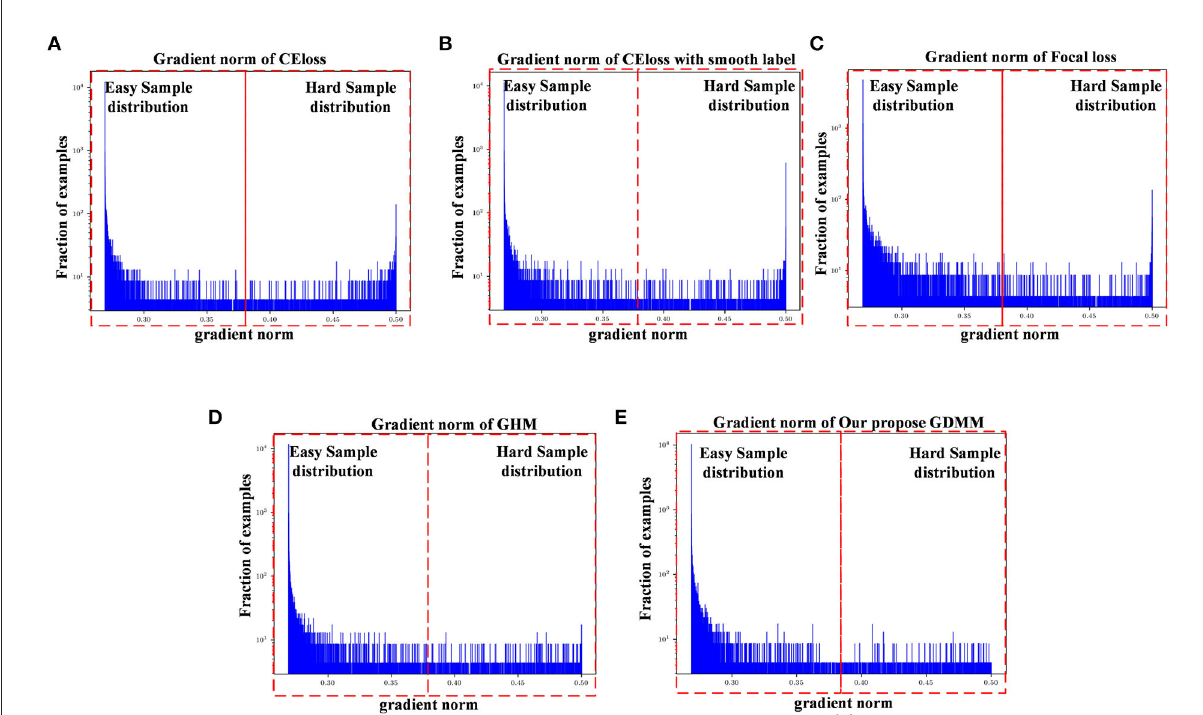
FIGURE3 Gradient density corresponding to different loss functions: (A) CE loss function, (B) CE loss function with label smoothing, (C) Focal loss function, (D) GHM, and (E) Our GDMM. Here, the x-axis represents the predicted value of the gradient norm from the model output, while the y-axis is the number of the grad value set, which is the subtraction between the predicted value and label value that can assess the sample difficulty level. We set two intervals to divide difficulty level, as 0–0.375 (easy sample region) and 0.375–0.5 (hard sample region) in our experiments, with 0.375 as the median value in the predicted value sets.